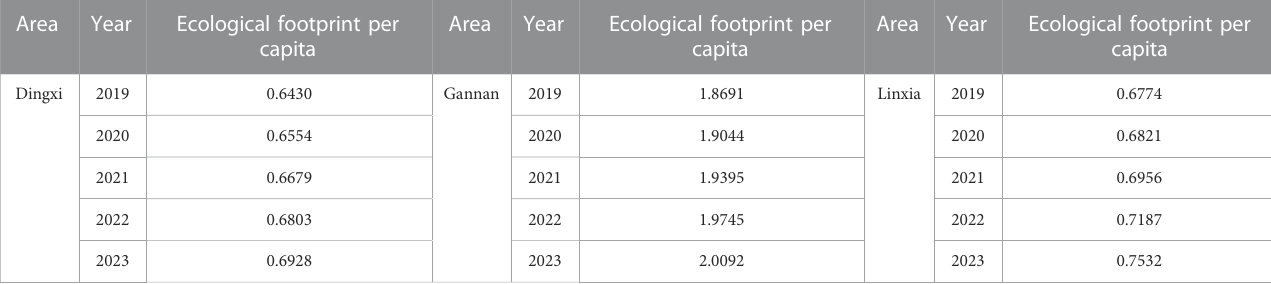
TABLE 2 Dingxi, Gannan and Linxia ecological footprint from 2019 to 2023